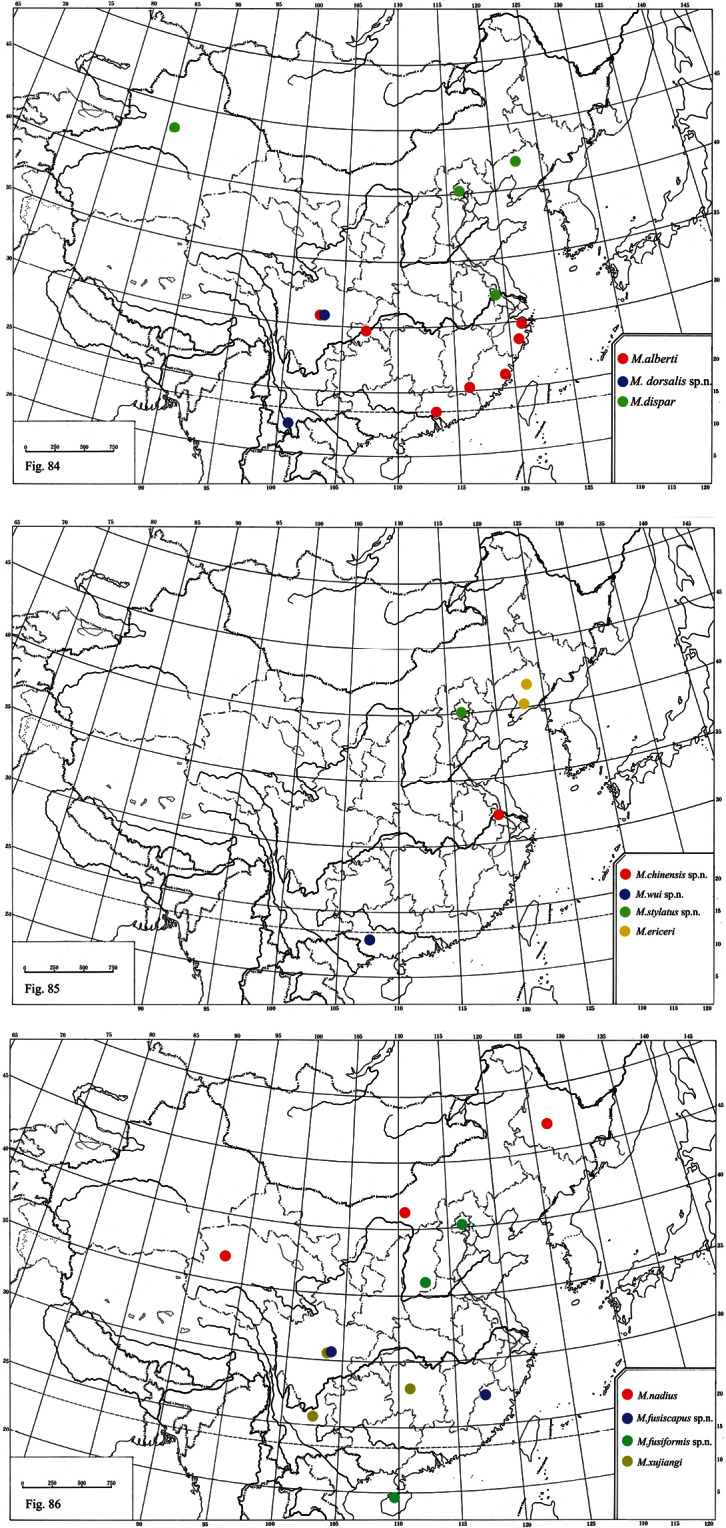
Distribution ofMetaphycus spp. in China.